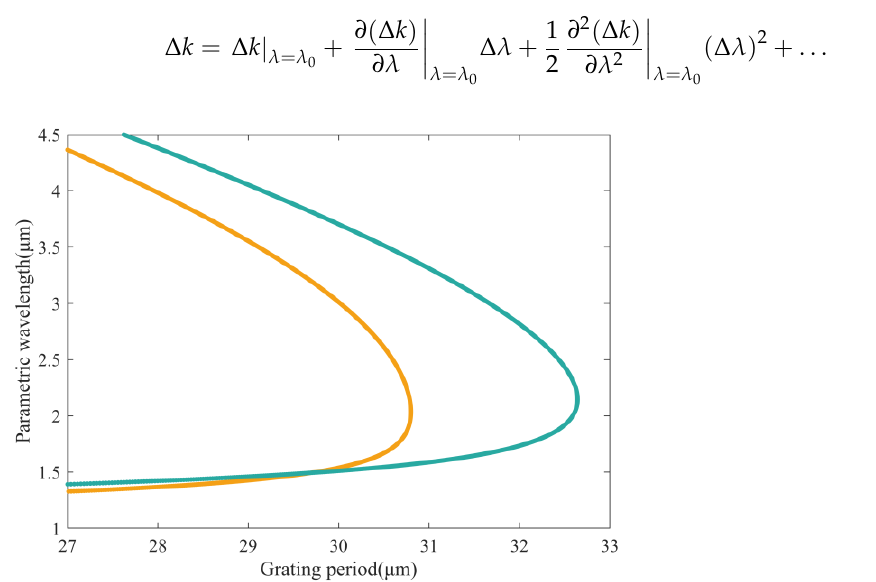
Figure 3. Tuning of the crystal grating period. The first term on the right side of the equation is 0 in the case of phase-matching, which is mainly determined by the second and higher order terms. The second term is group velocity mismatch (GVM), which generally does not equal zero. The value of the higher-order term in the equation is much smaller than the second term. The broadband phase-matching condition can also be explained by the difference frequency theory to some extent, citing the DFG conversion efficiency in Ref. [29], based on the assumption of a reference Gaussian input beam.